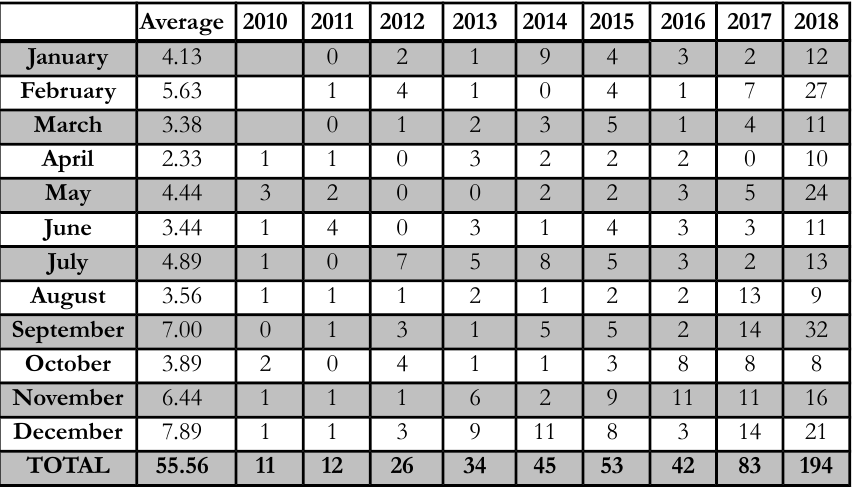
Table 1. Article submissions evolution from 2010 to 2018